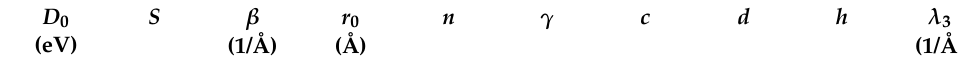
Table 3. The BO potential parameters (see Equations (1)–(6)) optimized for the InP crystal. D